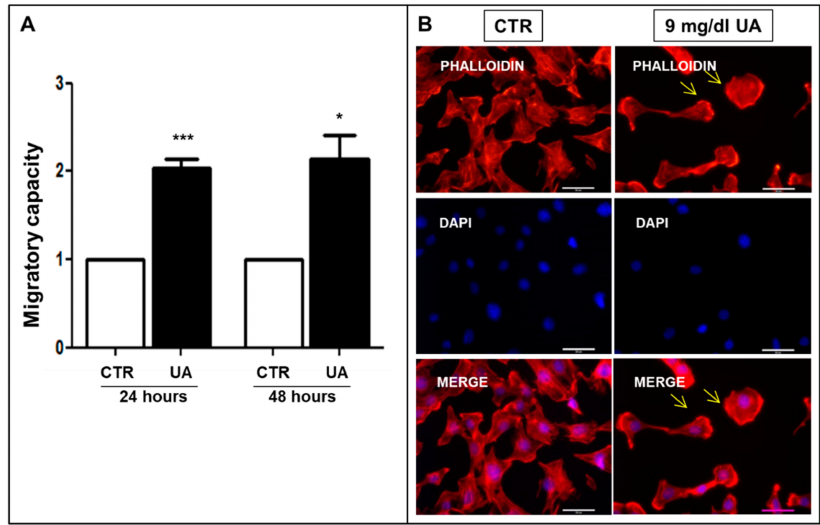
Figure 4. UA triggers F-actin different polymerization in MOVAS cells. ( A ) UA induced greater migratory capacity and ( B ) caused F-actin stress fiber organization, visualized with AlexaFluor 594- Phalloidin staining. Arrows point out cortical F-actin distribution. All results represent means ± SEM obtained from four/eight independent experiments and are expressed as fold change to CTR. * p < 0.05; *** p < 0.0001 vs. CTR. Magnification × 400, scale bar = 50 µ m. UA = Uric Acid; VSMC = Vascular Smooth Muscle Cells; CTR = Control, untreated cells; DAPI = 4 (cid:48) ,6-diamidino-2- phenylindole.